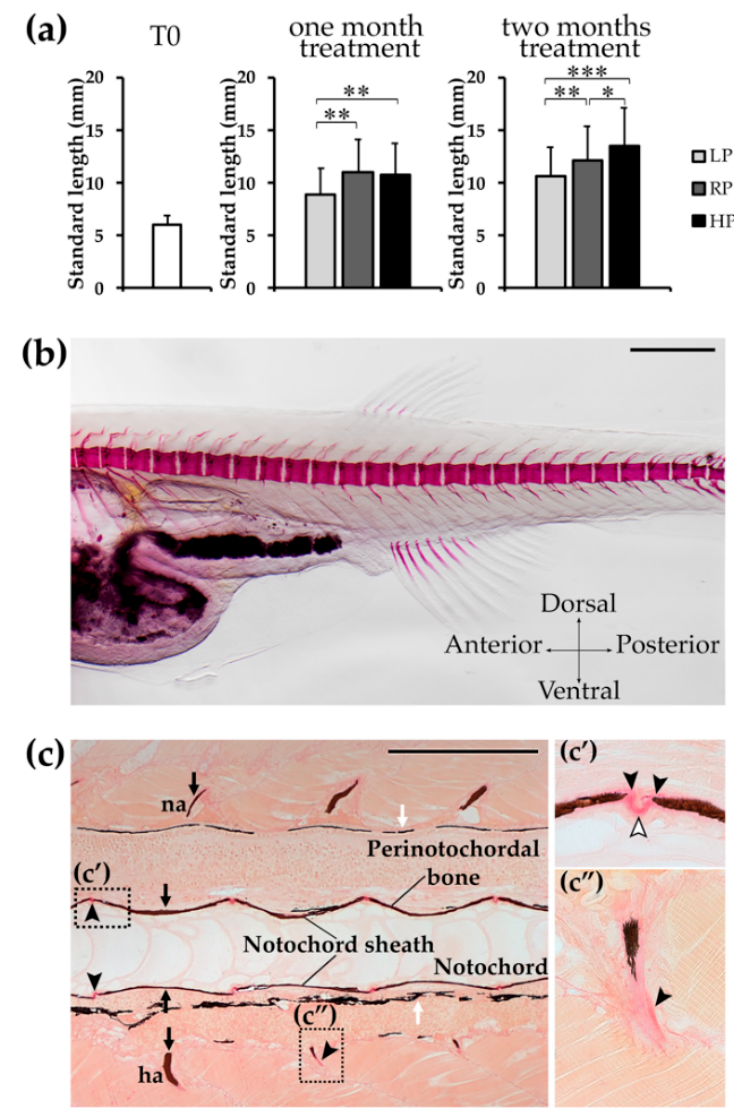
Figure 1. Zebrafish growth and T0 animals. ( a ) Morphometric analysis of WT zebrafish at the beginning of the experiment (T0, 28dpf) and after one and two months of treatment with the experimental diets. Animals treated with the low P diet (LP) are smaller than controls (RP) and high P diet (HP) treated animals, whereas HP zebrafish present a significantly increased standard length. Mann-Whitney test, *: p < 0.05; **: p < 0.01; ***: p < 0.001. ( b ) T0 zebrafish, prior the beginning of the experiment, stained with Alizarin red S shows normally developed vertebral column and forming vertebral bodies. No vertebral column malformations, nor vertebral body fusion or compression are present. Scale bar: 500 µ m. ( c ) Notochord sheath, perinotochordal membranous bone and neural (na) and haemal (ha) arches are mineralised in T0 animals, as shown by Von Kossa / Van Gieson staining on sagittal sections. Vertebral bodies are normally shaped and spaced. High magnification panels show ( c’ ) vertebral endplates with osteoid (black arrowheads) and intervertebral ligament (white arrowhead, see Figure 6a for details), ( c” ) haemal arch with non-mineralised collagen matrix (black arrowhead). Mineralised bone: brown (black arrows); pigment: black (white arrows), non-mineralised collagen matrix / osteoid: red (black arrowhead). Scale bar: 200 µ